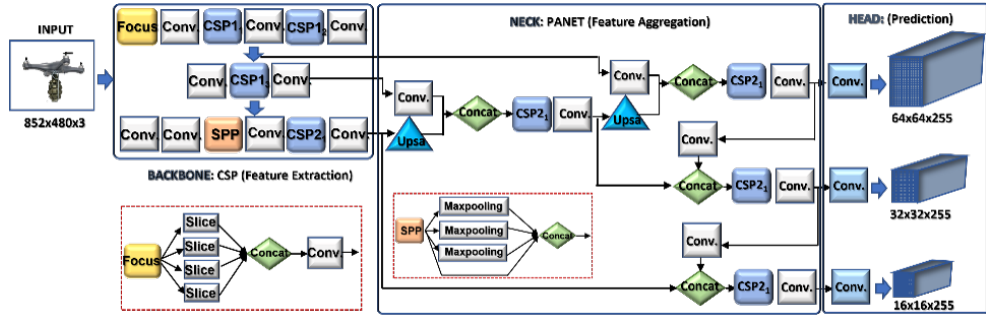
Figure 4. ALIEN model with its the underlying structures. The backbone layer comprises cross partial network (CSP) and focus for feature extraction. The neck layer consist of path aggregation network for feature aggregation, while the head layer has the YOLOv5 for actual prediction.